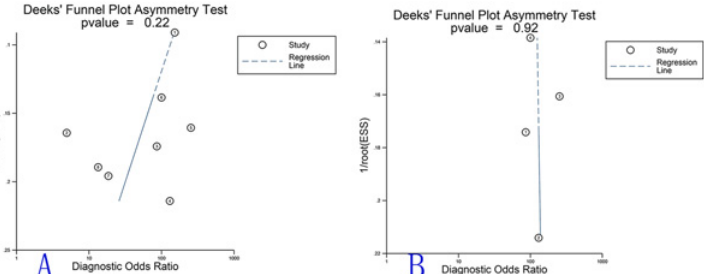
Fig 7. The overall Deeks' Funnel plots. A. The overall Deeks' test of the diagnostic meta-analysis of the 8 included studies; the overall p value was 0.22. B. The Deeks ’ test for ALK in diagnosis of bladder IMTs; the p value was 0.92. The dotted line indicates the regression